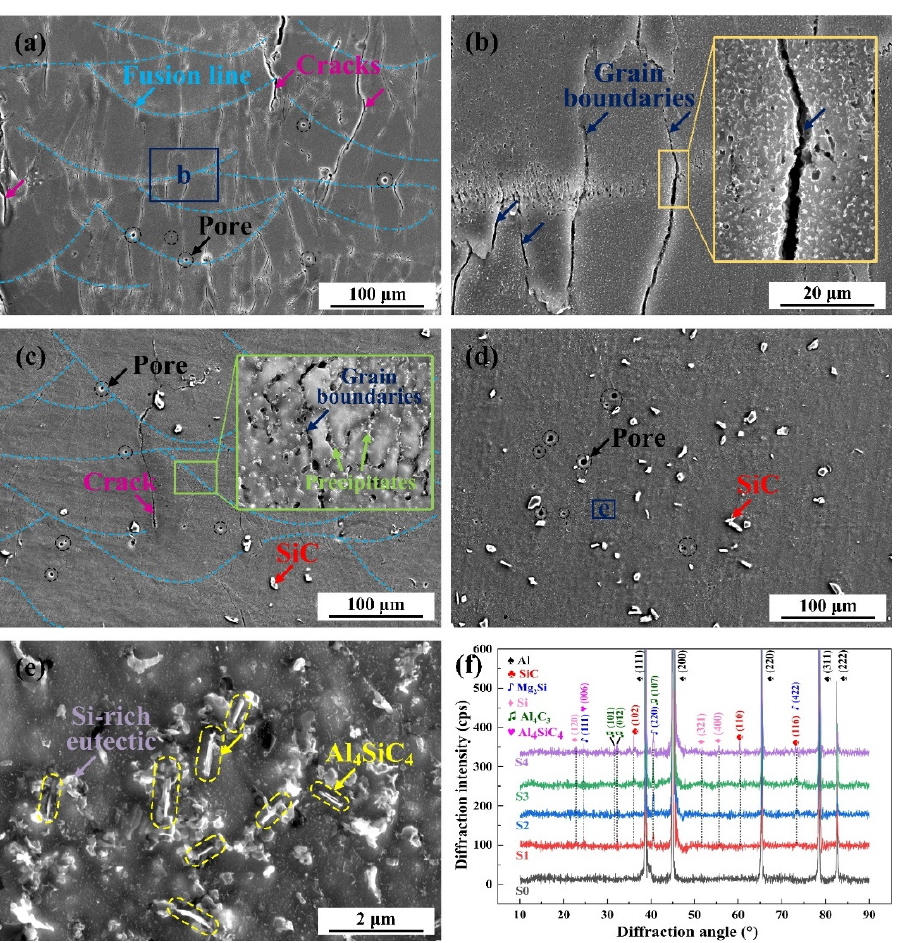
Figure 2. SEM images of the as-printed ( a , b ) S0 sample, ( c ) S2 sample, and ( d , e ) S4 sample. ( f ) XRD diffraction patterns of the as-printed samples.